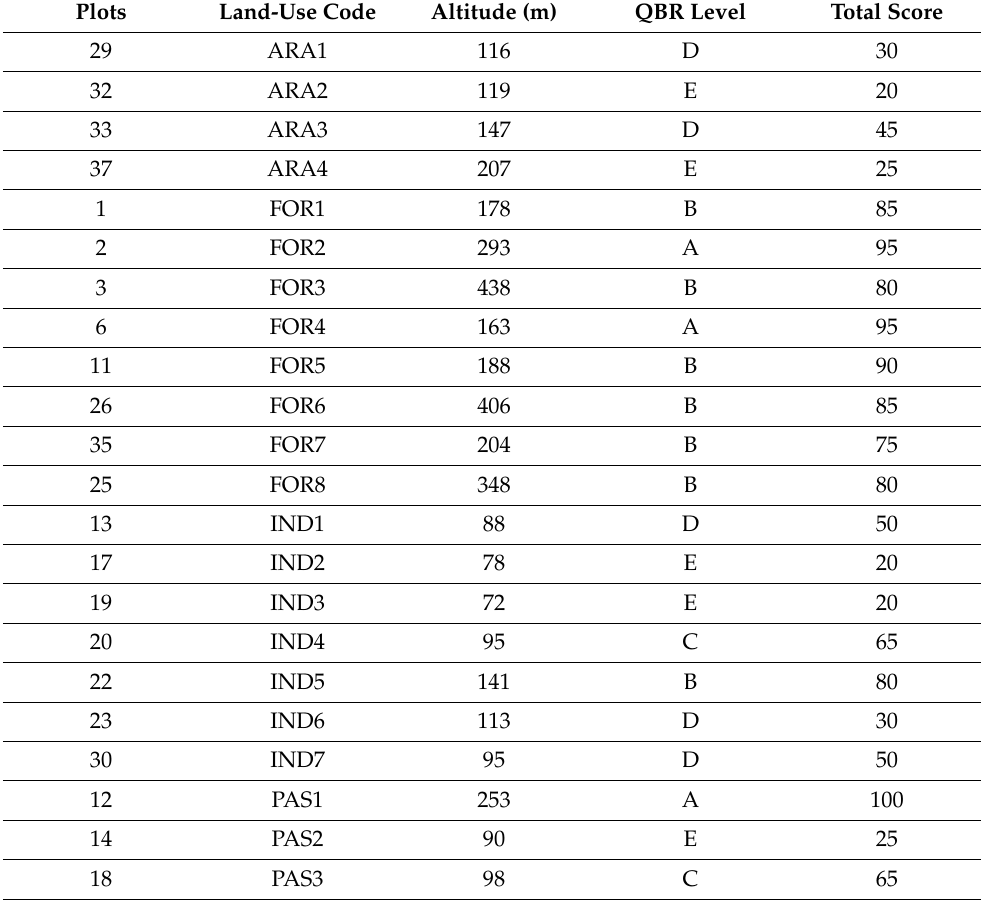
Table 1. Plot number, land-use code, altitude, QBR quality level, and total score for all 37 sampling plots. Plots Land-Use Code Altitude (m) QBR Level Total